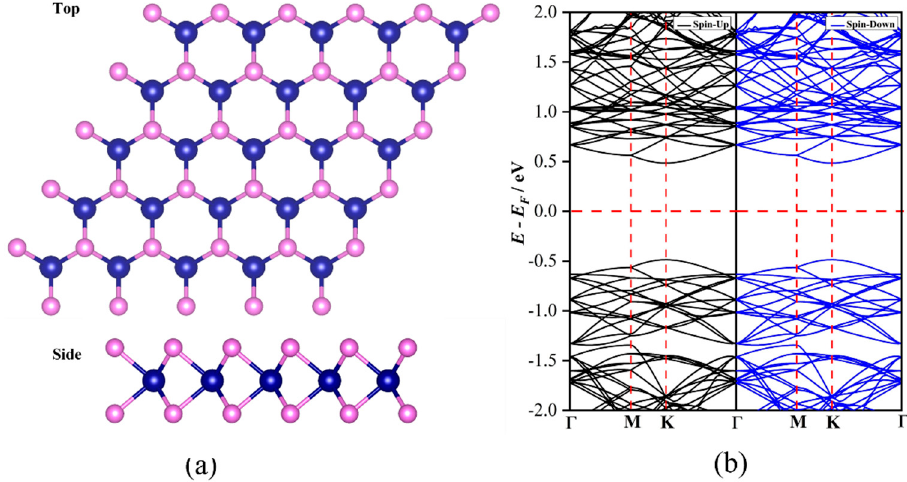
Figure 1. ( a ) The obtained stable configurations and ( b ) computed band structure for the pristine CrS 2 monolayer.